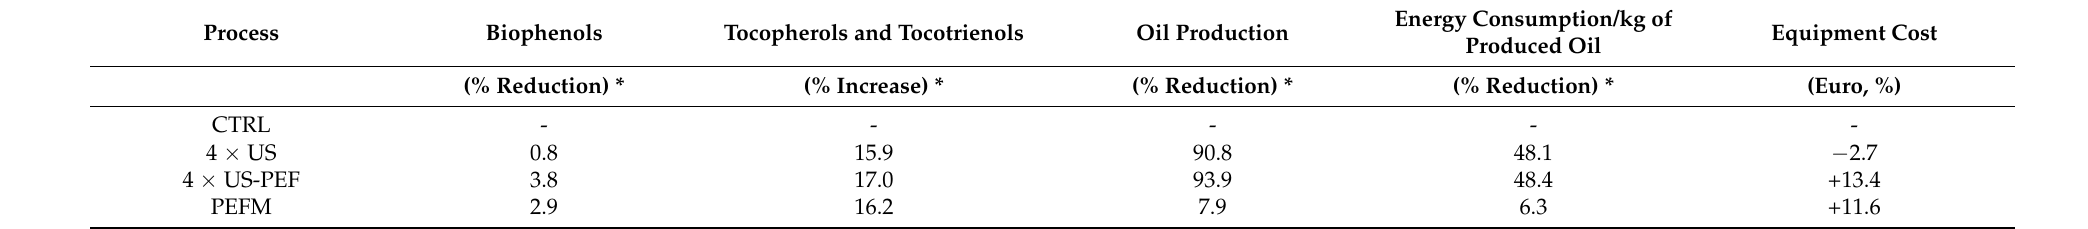
Table 5. Industrial trials: energy, costs and production